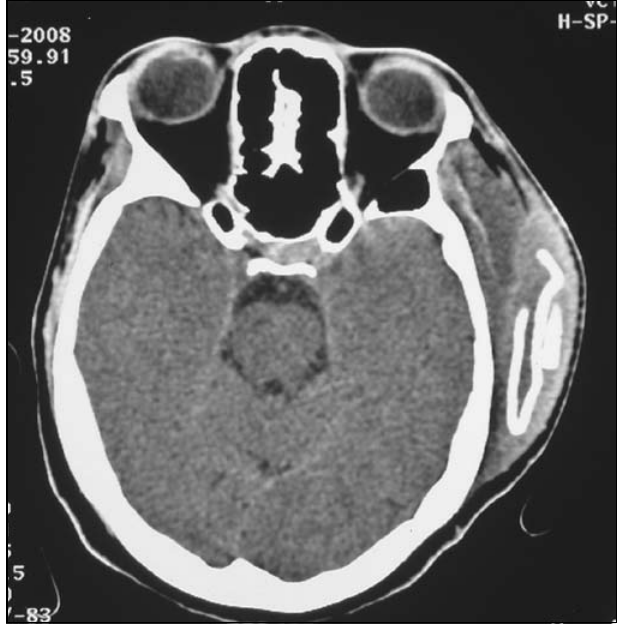
Fig. 1b. CT image showing Teflon felt in soft tissues of